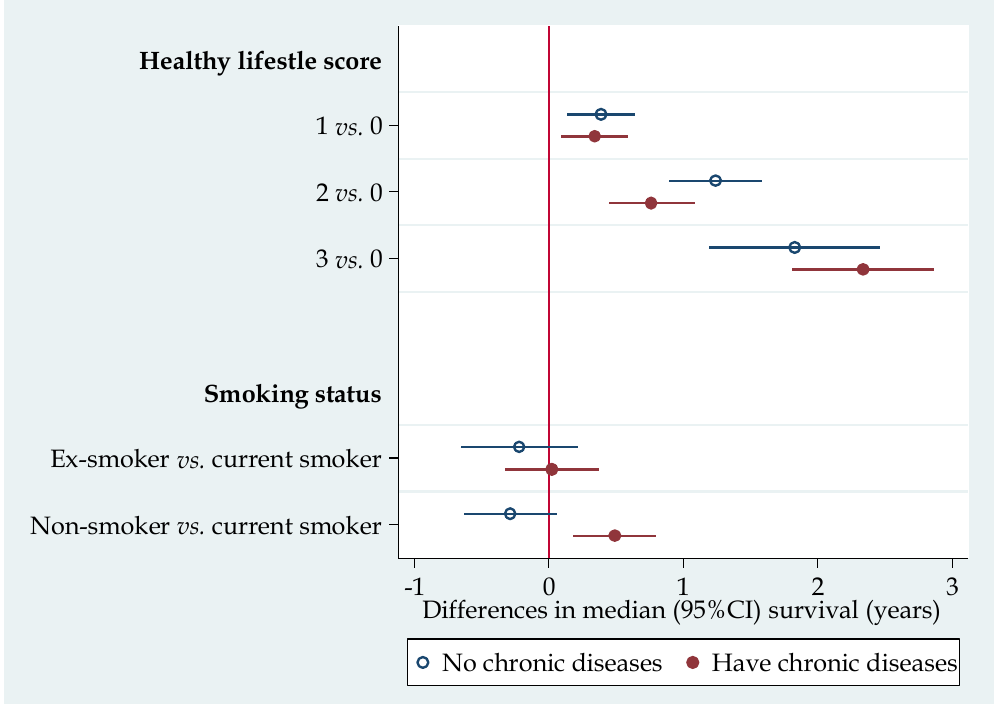
Figure 2. Median differences of survival according to healthy lifestyle score and smoking status stratified by status of chronic diseases. Results were from Laplace regression, adjusted for age, sex, residence, job (manual vs. non-manual) before age of 60 years, and alcohol drinking. Healthy lifestyle score included daily intake of fruit, vegetable, and having physical activity. Each factor scored 1. CI: Confidence Interval.